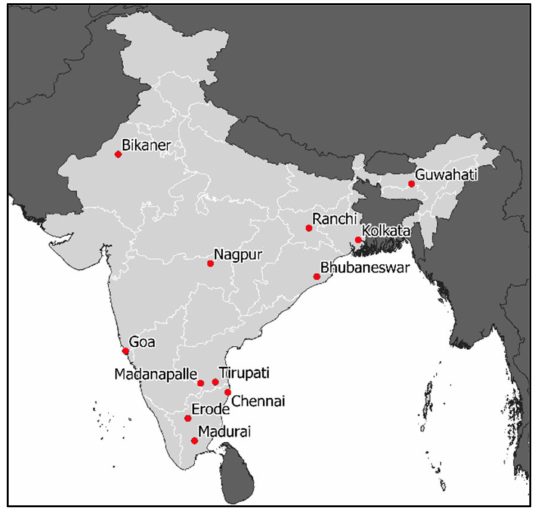
Figure 4. Location of synchronized pilot campaigns in September